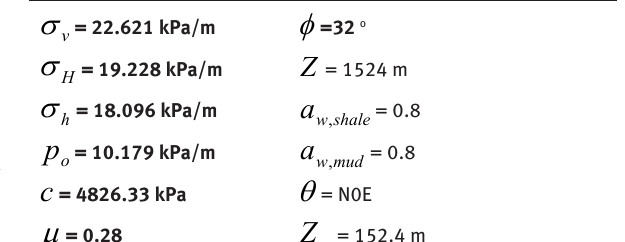
Table 1 : Data for well A1 used in the